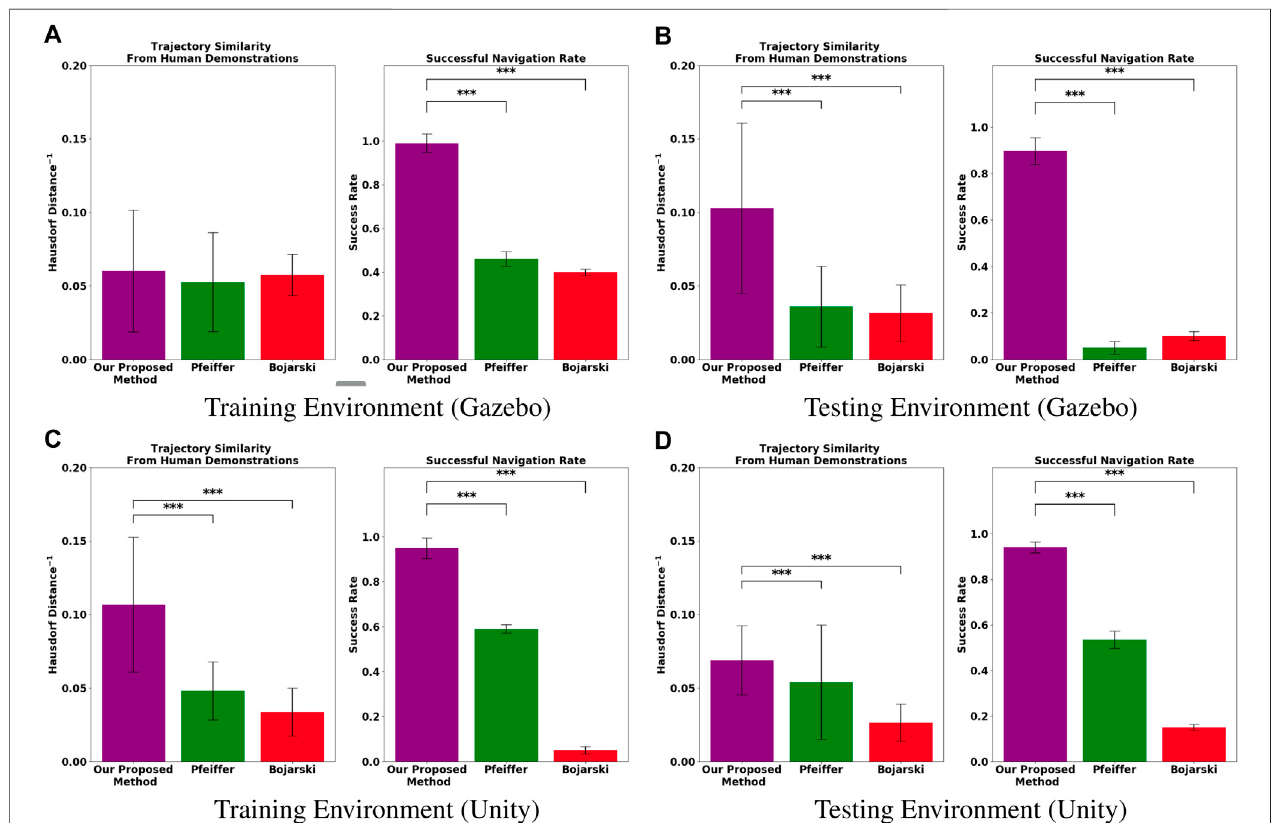
FIGURE4| Experimental resultsevaluatingtheperformancesofeachmodeltrainedusingthebaselinemethods,Bojarskietal.(2016)(red)andPfeifferetal.(2018) (green), and our proposed method (violet). The top row shows results of new tasks performed within a (A) training environment, and tasks performed in a different (B) testing environment, both of which were simulated in Gazebo. The bottom row shows experiments conducted in (C) training and (D) testing environments simulated in Unity. The bar plot titled “ Trajectory Similarity from Human Demonstrations ” (left) uses Modi fi ed Hausdorff distance to quantify how similar the paths resulting from thepolicyrolloutsaretoanaverageofallhumandemonstratedpathsforthesametask.Thebarplottitled “ SuccessfulNavigationRate ” (right)depicttheirsuccessrates. The error bars represent the standard error computed over 50 trials. “ *** ” indicates statistical signi fi cance, as computed using a Bonferroni corrected p -value of 0.025.